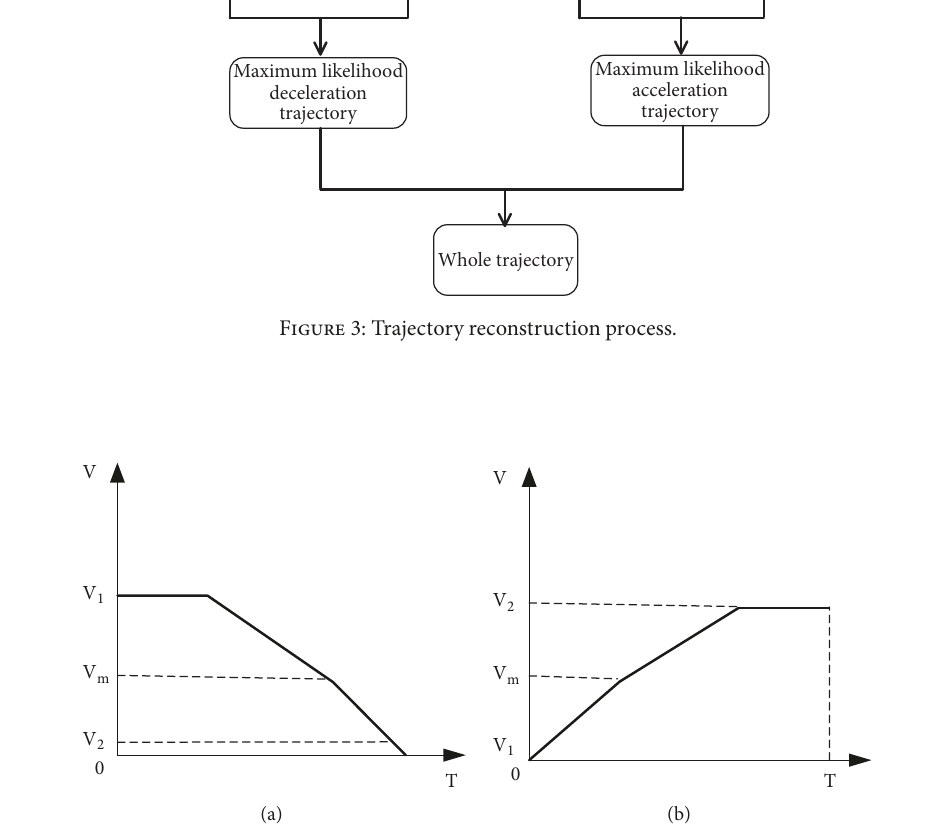
Figure 4: Relationship between speed and time in deceleration model (a) and acceleration model